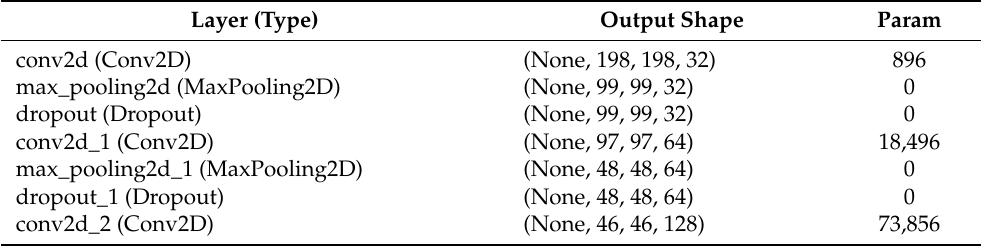
Table 3. Variation of map size according to layer number of the developed CNN model.